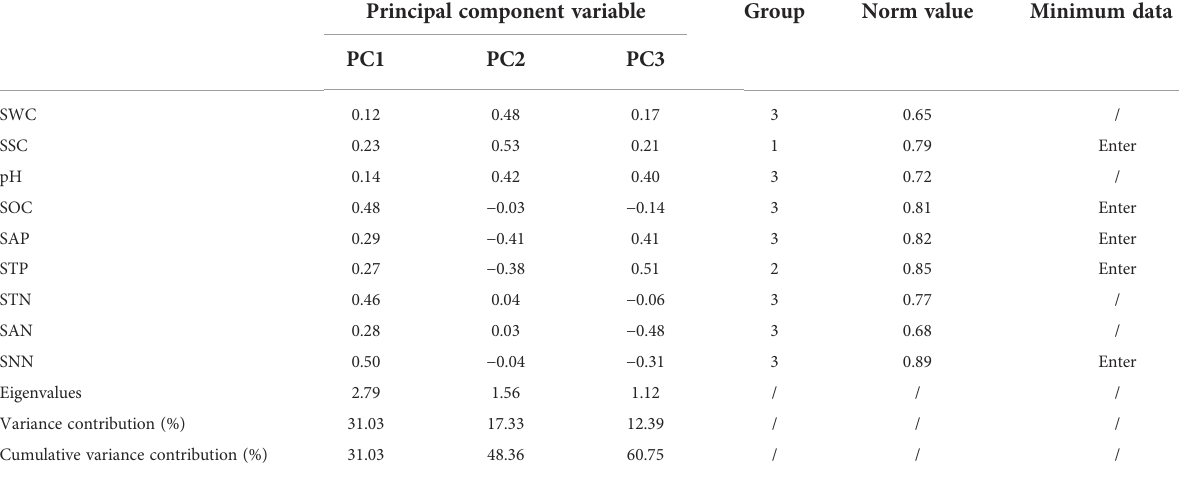
TABLE 3 Load matrix and norm values of